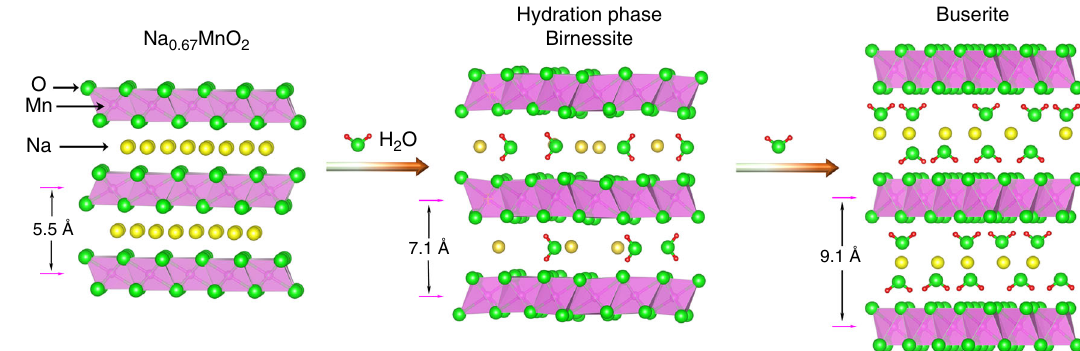
Fig. 1 Structural illustration of water insertion. Schematic illustration of P2-Na 0.67 MnO 2 , birnessite, and buserite